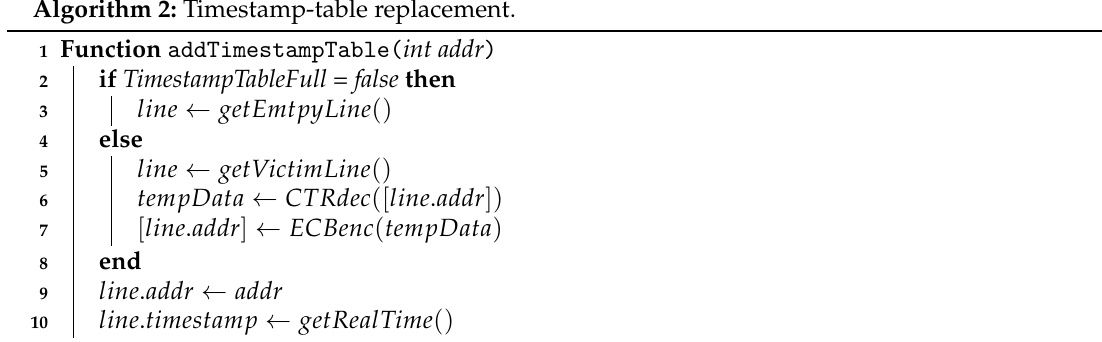
Algorithm 2: Timestamp-table